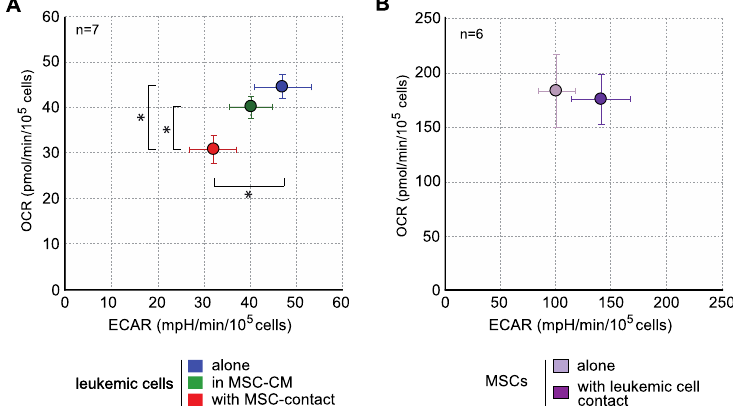
Figure 3. MSCs decrease the energy metabolism of leukemic cells. Energy metabolism was assessed through the evaluation of mitochondrial respiration (OCR) and glycolysis (ECAR) and with Seahorse XFe96 ( n = 7). ( A ) Analysis of energy metabolism in KG1a cells. ( B ) Analysis of energy metabolism in MSCs. * p < 0.05.